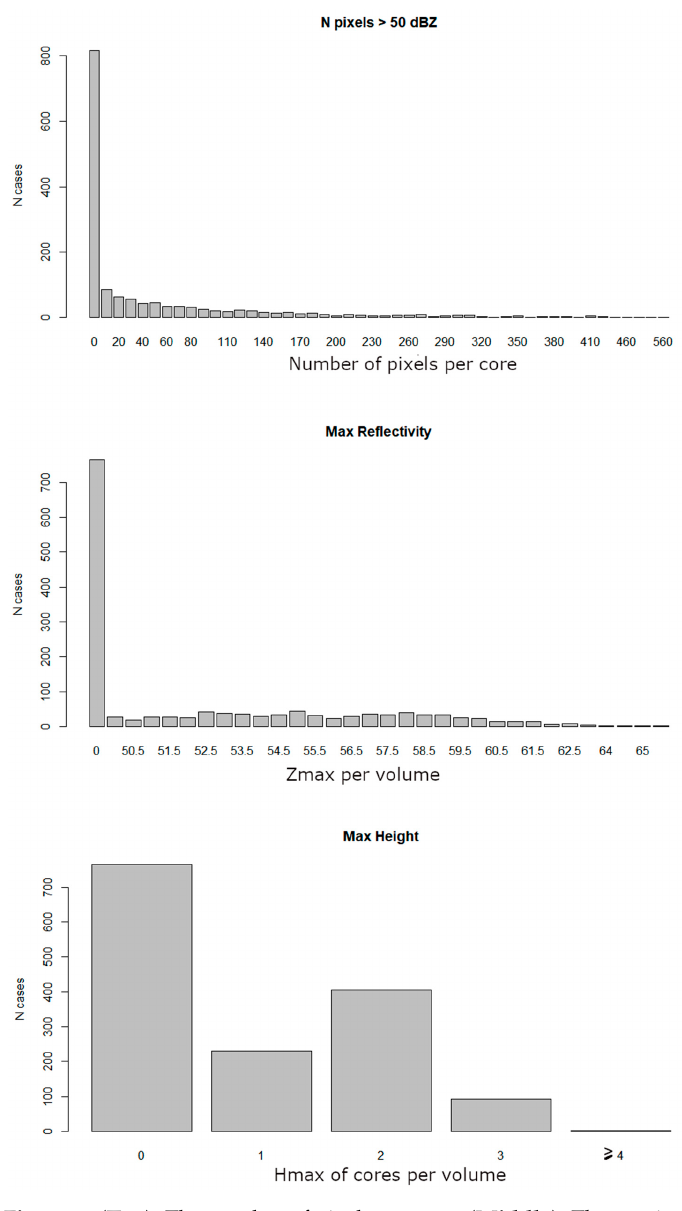
Figure 8. ( Top ): The number of pixels per core. ( Middle ): The maximum reflectivity detected in each Figure 8. Top : The number of pixels per core. Middle : The maximum reflectivity detected in each volume. ( Bottom ): The maximum height at which the core per volume was volume. Bottom : The maximum height at which the core per volume was detected. The maximum reflectivity (middle panel of Figure 8) varies from 50 and 65.5 dBZ, but 70.09% range between 53 and 59.5 dBZ, which can be considered as the more common